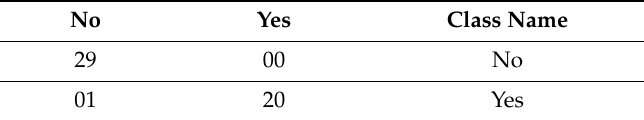
Table 24. Matrix with reduced dimensions for fold 4.